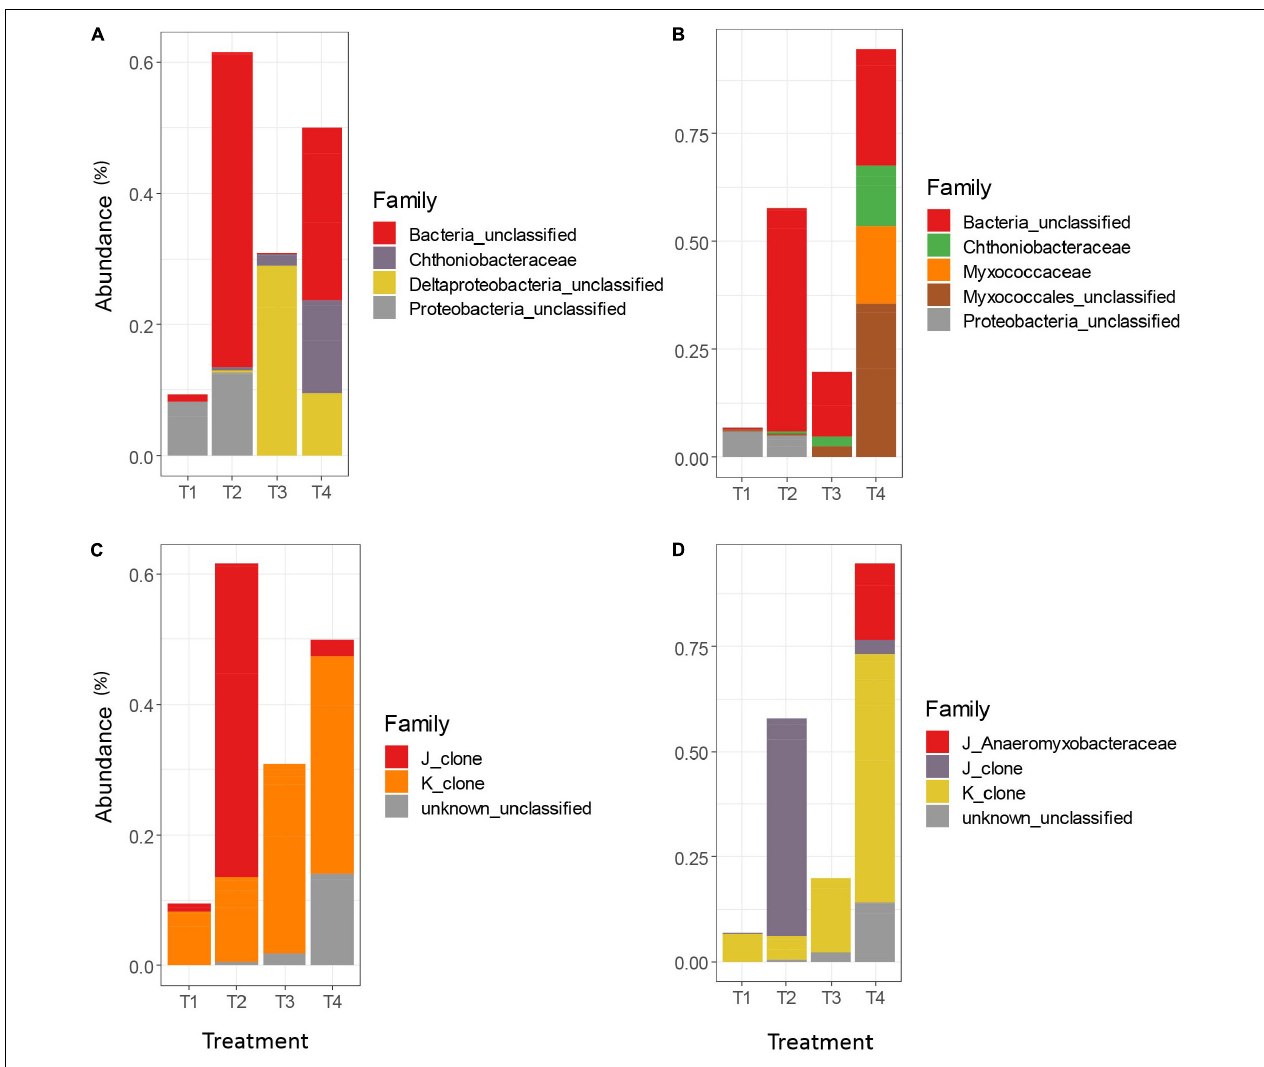
FIGURE 5 | Differentially abundant nrfA taxa among the top 100 OTUs for the AGC-0.03 method classified using the FunGene database (A) , the MCC-0.03 method using the FunGene database (B) , the AGC-0.03 method using the clade-based database (C) , and MCC-0.03 using the clade-based database (D) . Significance of differential abundance assessed at α =